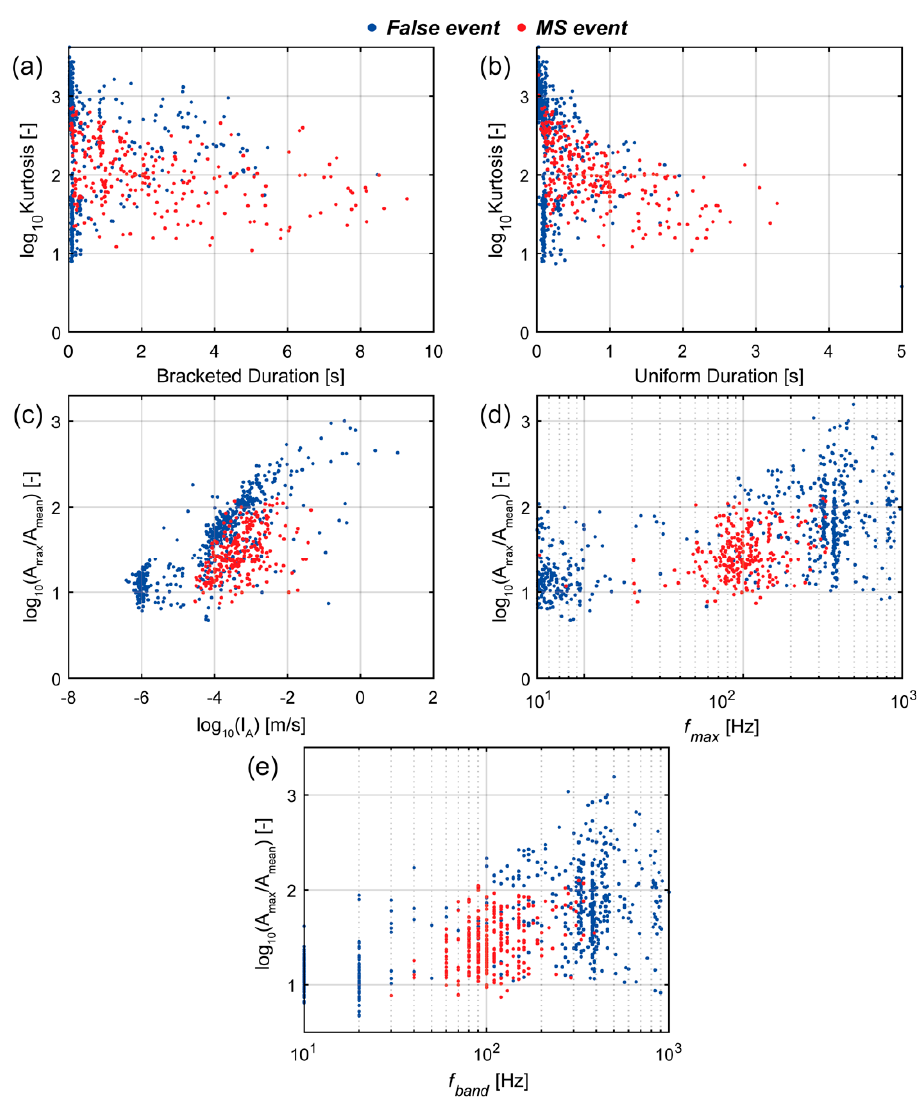
Figure 7. Results of the comparison between manually classified false and MS events based on time- and frequency-domain features. The following plots are presented: kurtosis vs. bracketed duration ( a ), kurtosis vs. uniform duration ( b ), maximum amplitude normalized to the mean of the envelope of the signal (A max /A mean ) vs. Arias intensity (I A ) ( c ), A max /A mean vs. the frequency peak of power spectra (f max ) ( d ), and the 10-Hz frequency band with the maximum spectral content (f band ) ( e ).